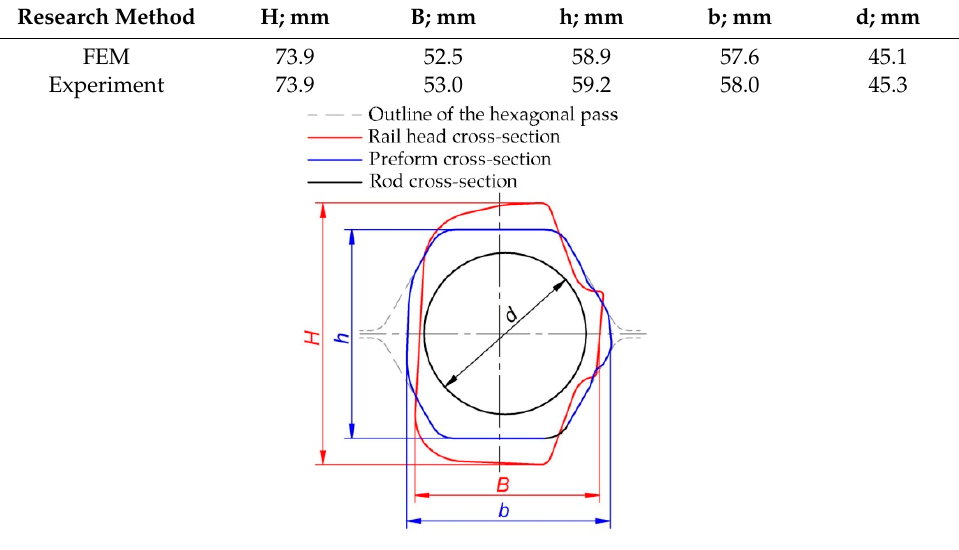
Figure 17. Shape of the rods after the second stage of rolling, with cavities visible on the end faces. During the tests, force parameters of the process were also registered. More precisely, torques were recorded for longitudinal rolling and radial forces, and rolling torques were registered for skew rolling. Torque curves for longitudinal rolling in the hexagonal pass are shown in Figure 18.